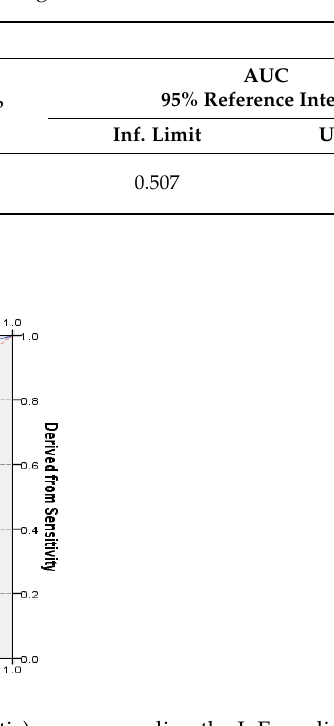
Figure 3. The ROC (receiver operating characteristic) curve regarding the IgE prediction specific to wheat flour vs. remission of the disease.